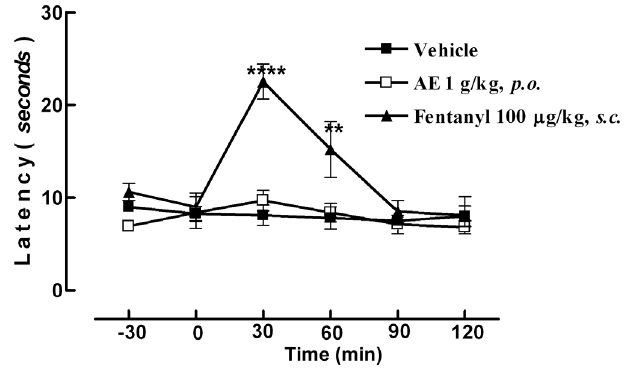
FIGURE 1- Effect of the acetone extract (AE) of Anacardium occidentale or fentanyl on the nociceptive response of mice in the hot-plate test. The symbols and vertical bars express means ± S.E.M. of the latency for the nociceptive behavior. ** p < 0.01, **** p < 0.0001 when compared with the vehicle control group (Two tail unpaired Student’s t test). n = 8.